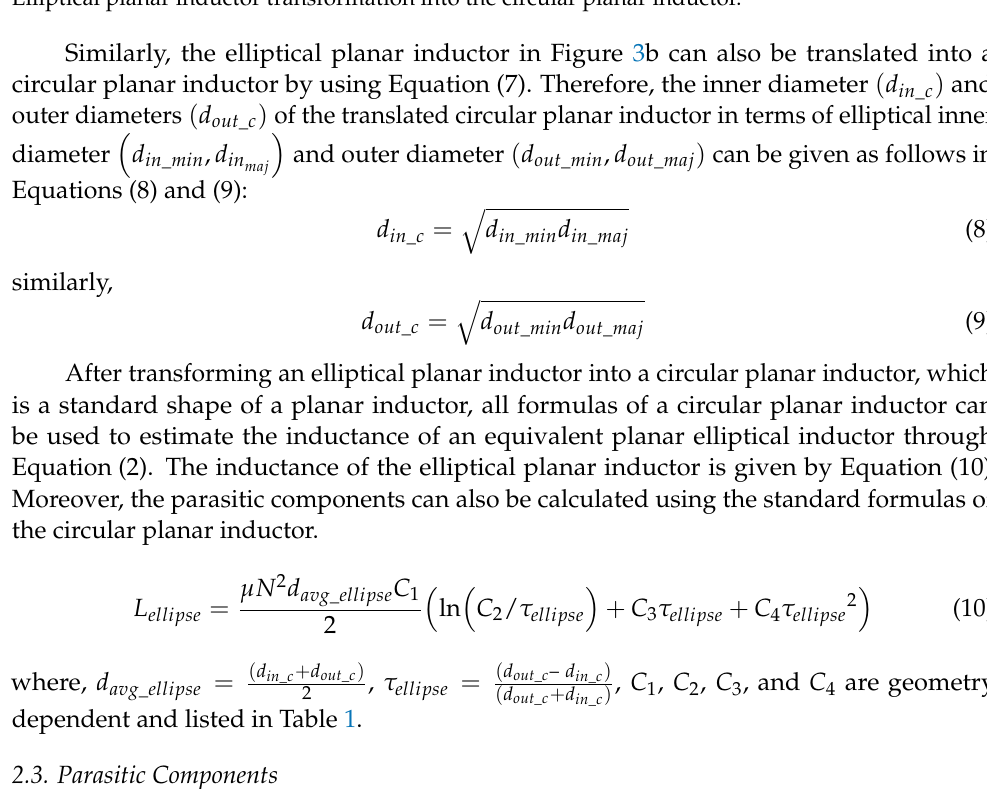
Figure 3. Area transformation technique ( a ) Ellipse area transformation to a circular shape ( b ) Elliptical planar inductor transformation into the circular planar inductor.